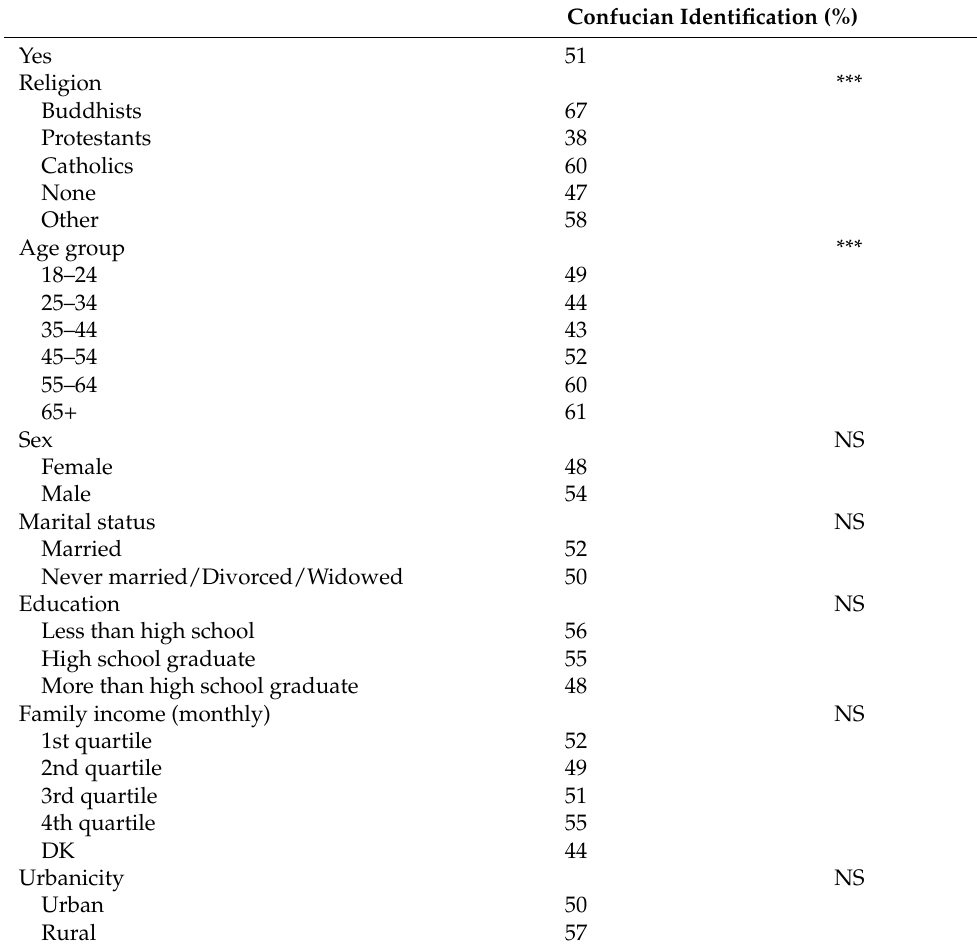
Table 1. Confucian identification by religion, age, sex, marital status, education, family income, and urbanicity (%), 2016 Korean General Social Survey